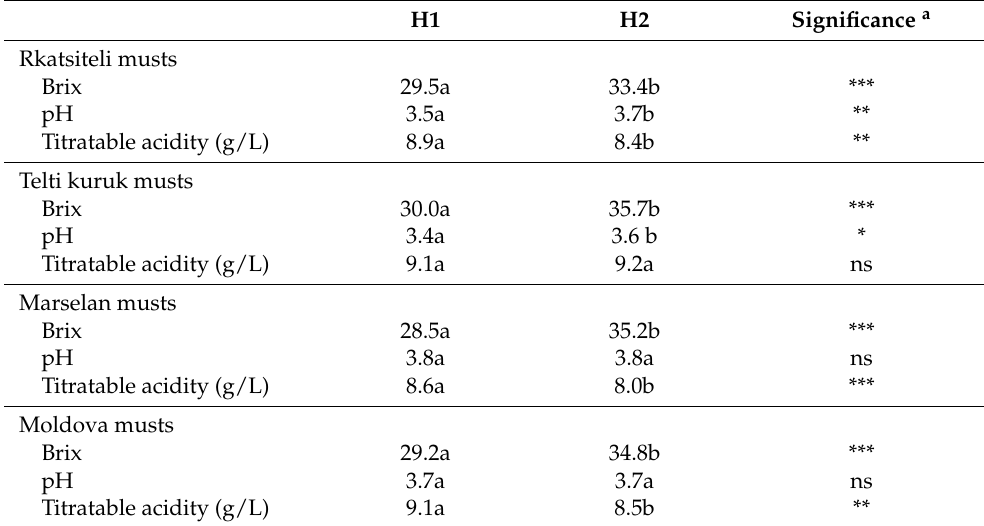
Table 3. Influence of harvest date (H1, H2) on the chemical compositions of grape musts.